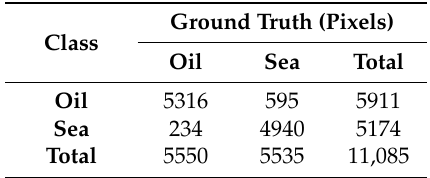
Table 10. Confusion matrix achieved by SVM based on 9 π /4 mode features.